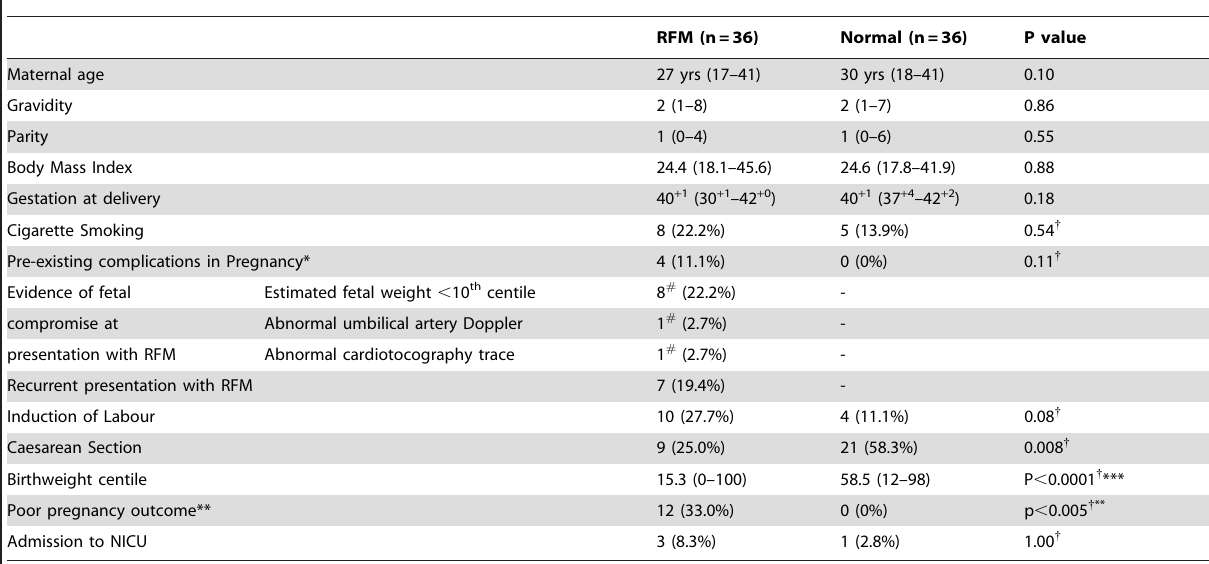
Table 1. Demographic details of subjects with